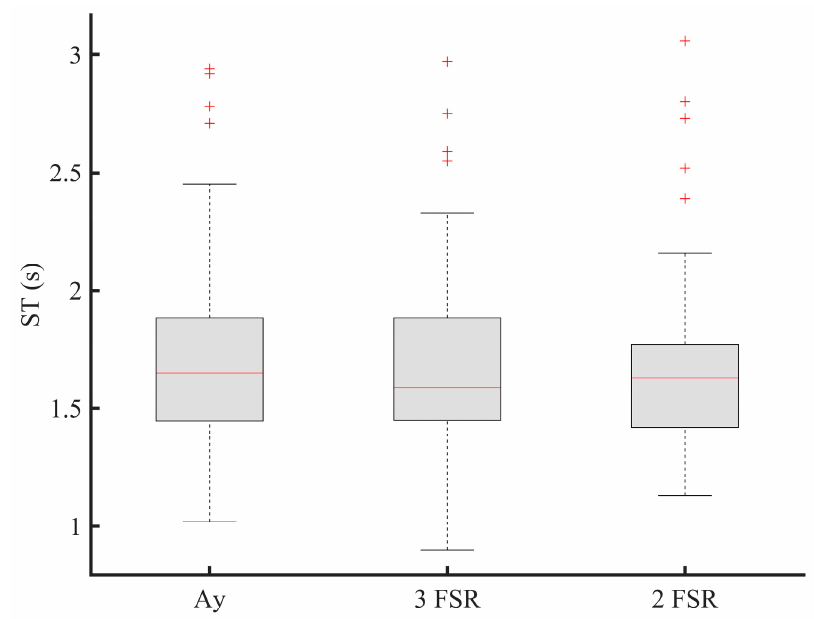
Figure 8. Stride time (ST) estimation for sensor reduction (Ay: y-acceleration; FSR: force sensitive resistor; 3-FSR: use of three FSRs; 2-FSR: use of two FSRs).